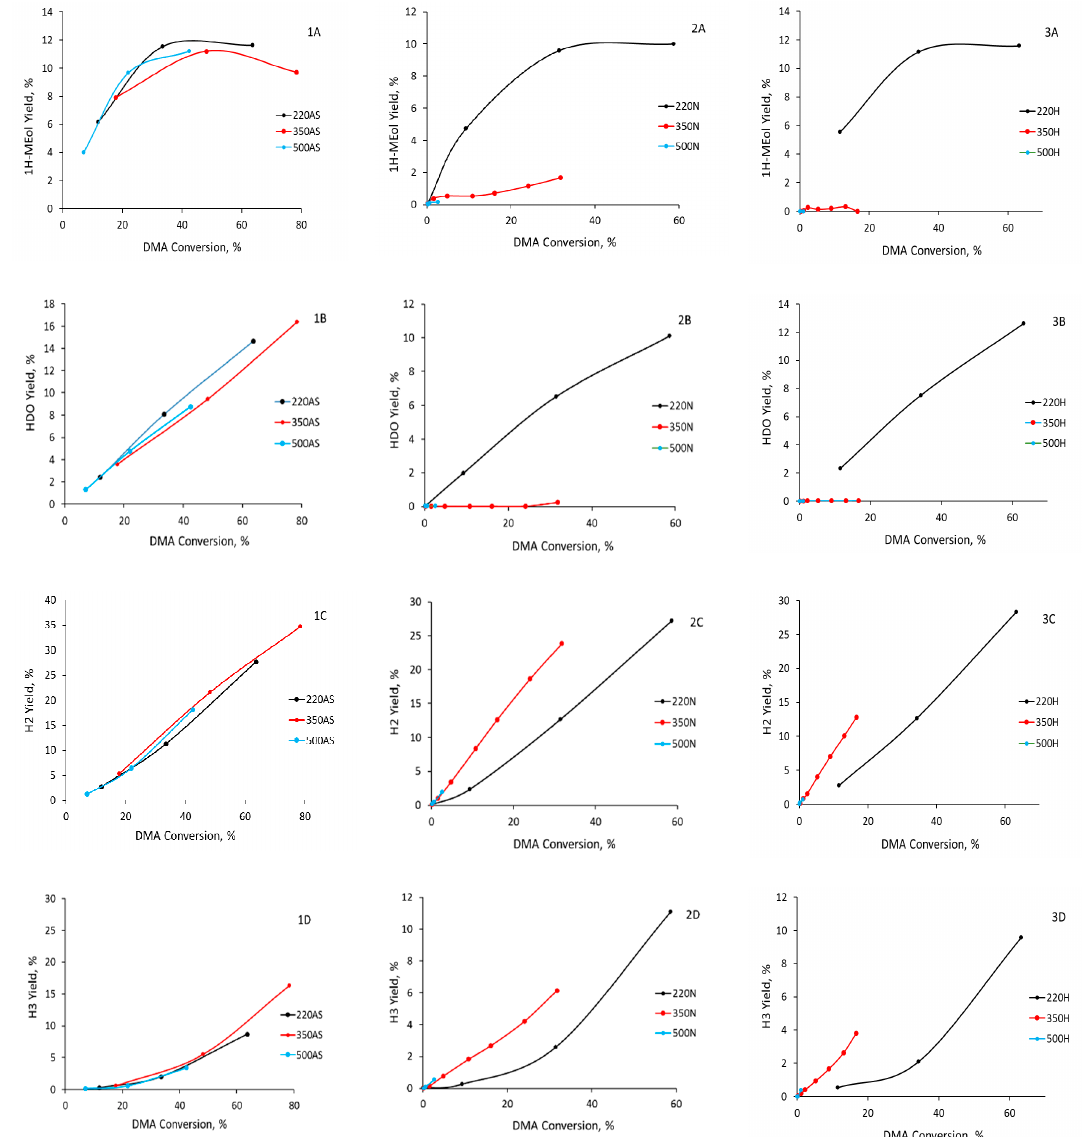
Figure 8. The change of the yield of reaction products ( A : 1HMEol, B : HDO, C : H2, D : H3) with a dependence on the DMA conversion observed over the samples prepared by the thermal treatment of CuZn-P in air ( 1 ), nitrogen ( 2 ) and hydrogen ( 3 ).